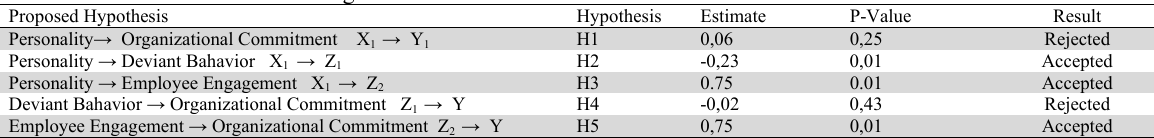
Direct Effect Path Coefficient Testing